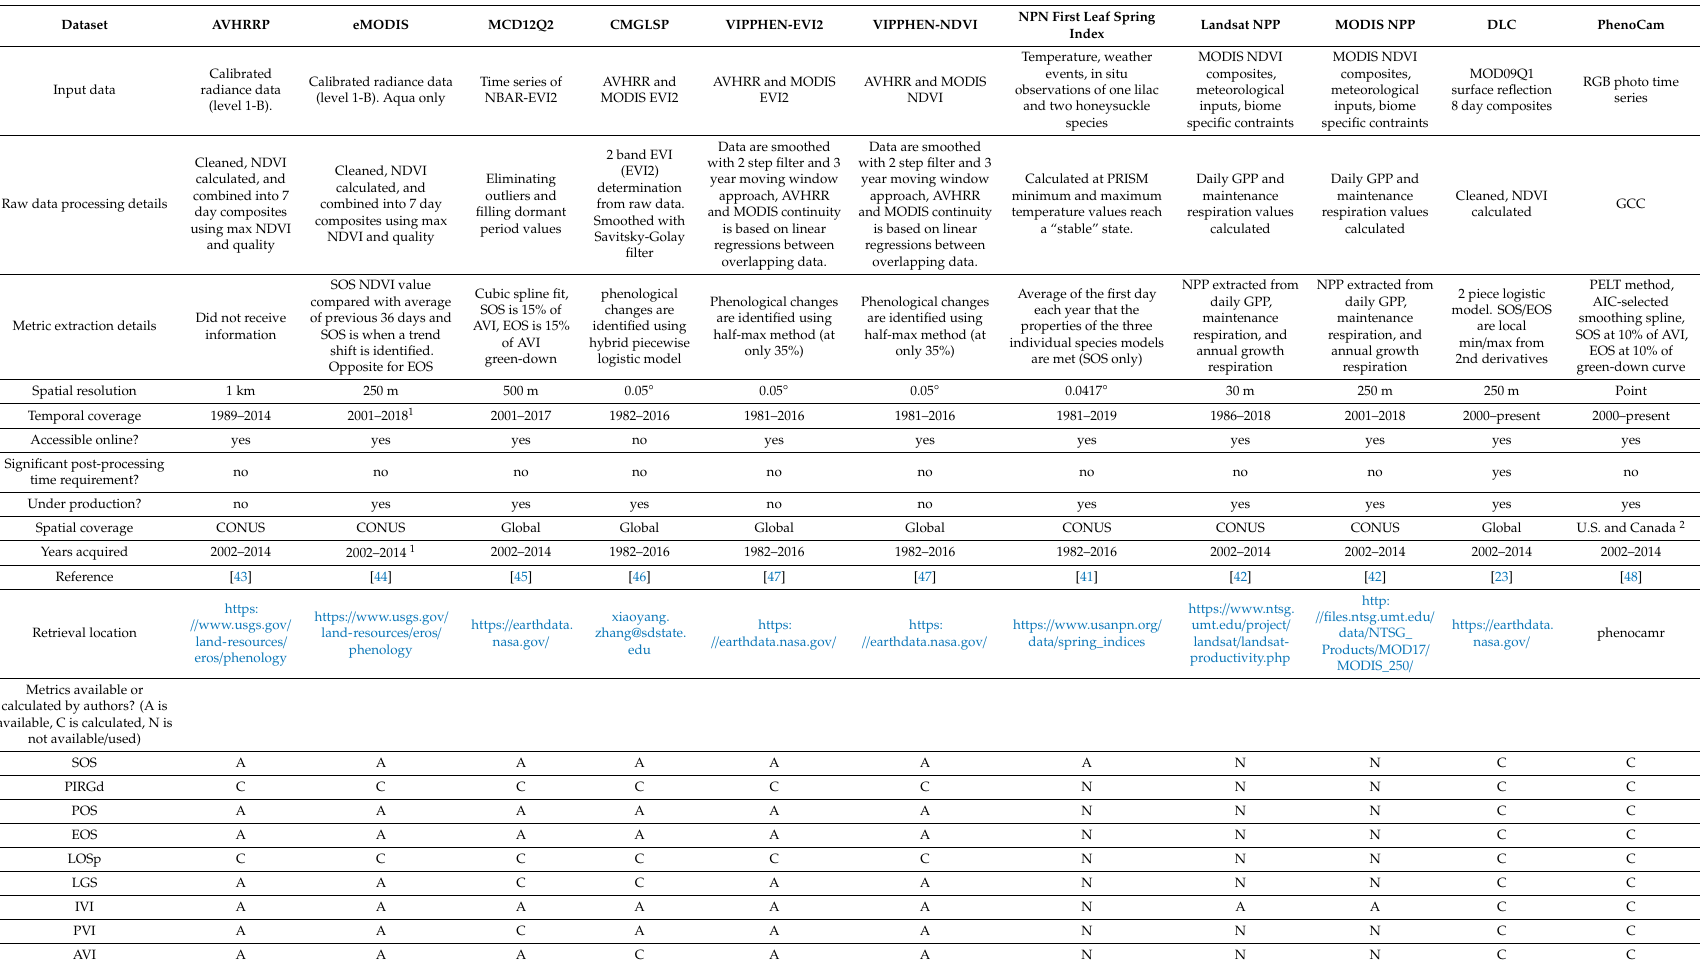
Table A1. Detailed table of phenology and productivity